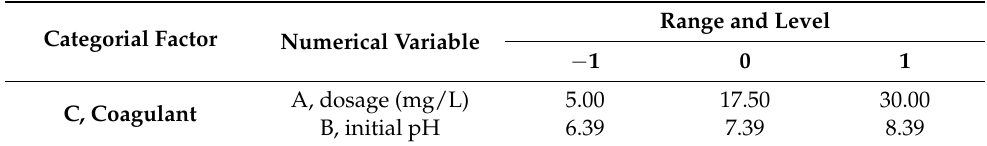
Table 3. Range and level for